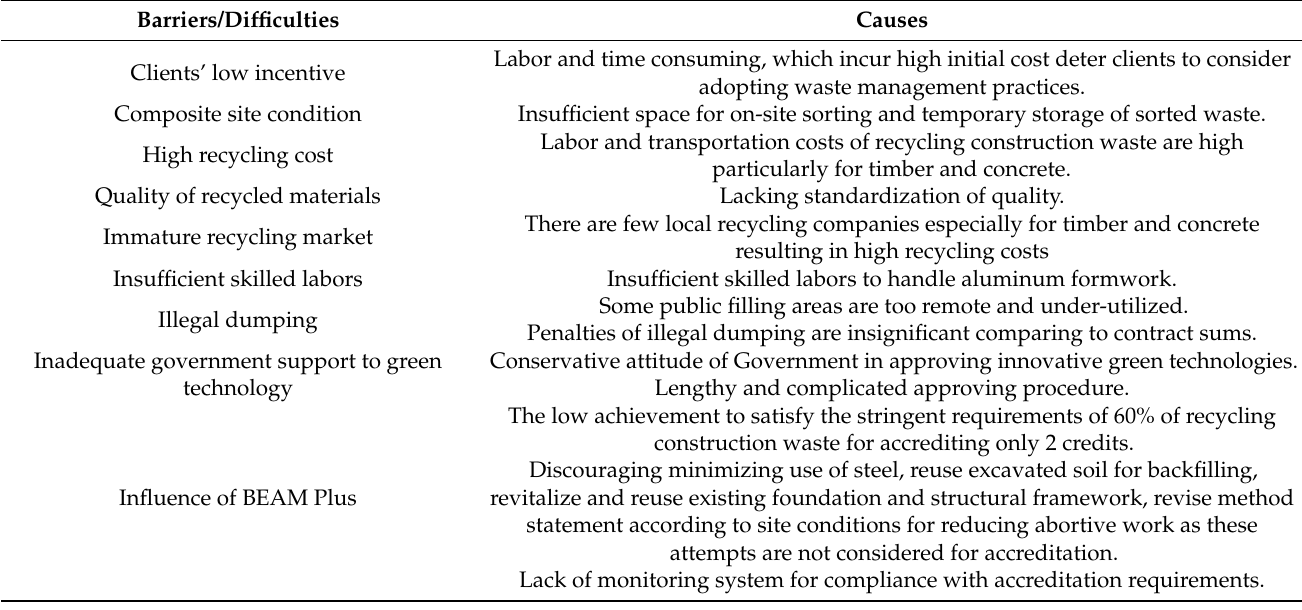
Table 2. Barriers and difficulties in construction waste